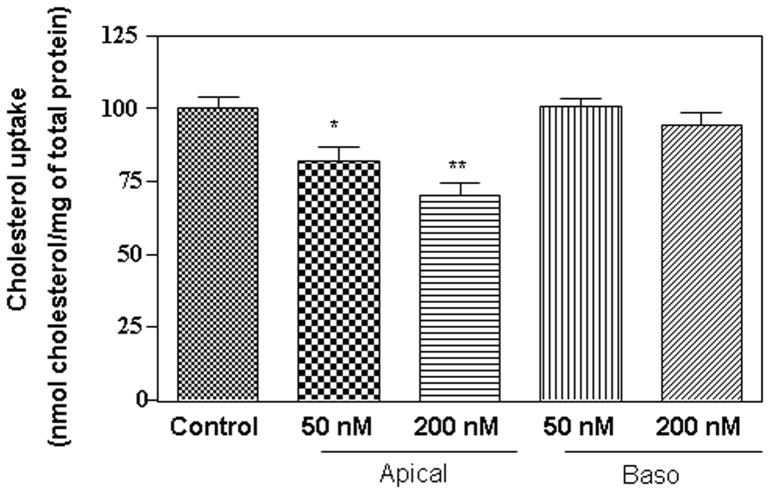
Effects of the administration of PYY (1–36) to the apical or basolateral medium on cholesterol uptake in Caco-2/15 cells.Differentiated Caco-2/15 cells were cultured for 24 h in MEM containing 50 nM or 200 nM of PYY in their apical or basolateral medium, in the presence of 100 µM cholesterol in apical (with 250 000 dpm [14C]-cholesterol). Data are reported as % of control values representing 100%. Values represent the mean ± SD for n = 3 separate experiments in each group. * P<0.05 vs. controls, ** P<0.01 vs. controls.